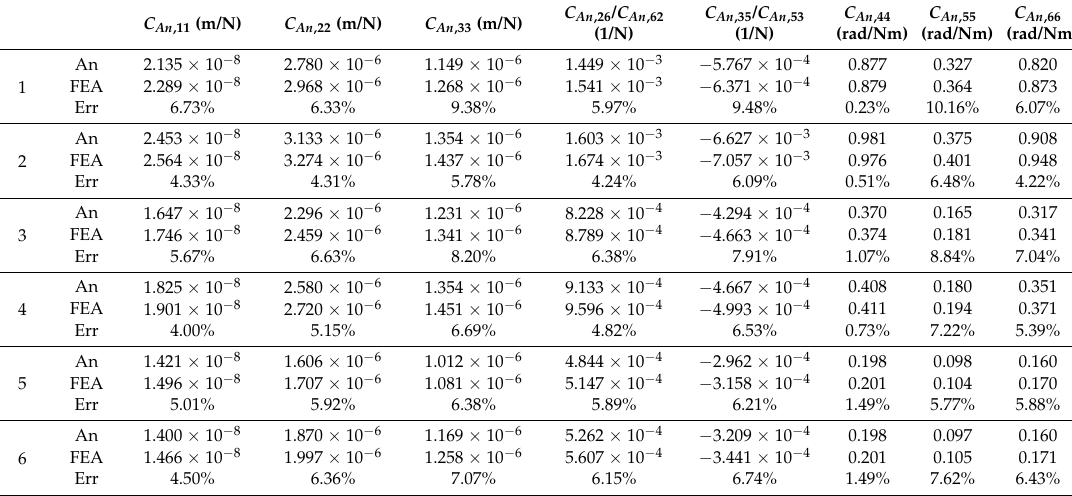
Table 2. Comparison of compliance elements between the analytical results and the FEA results (denoted by An and FEA,